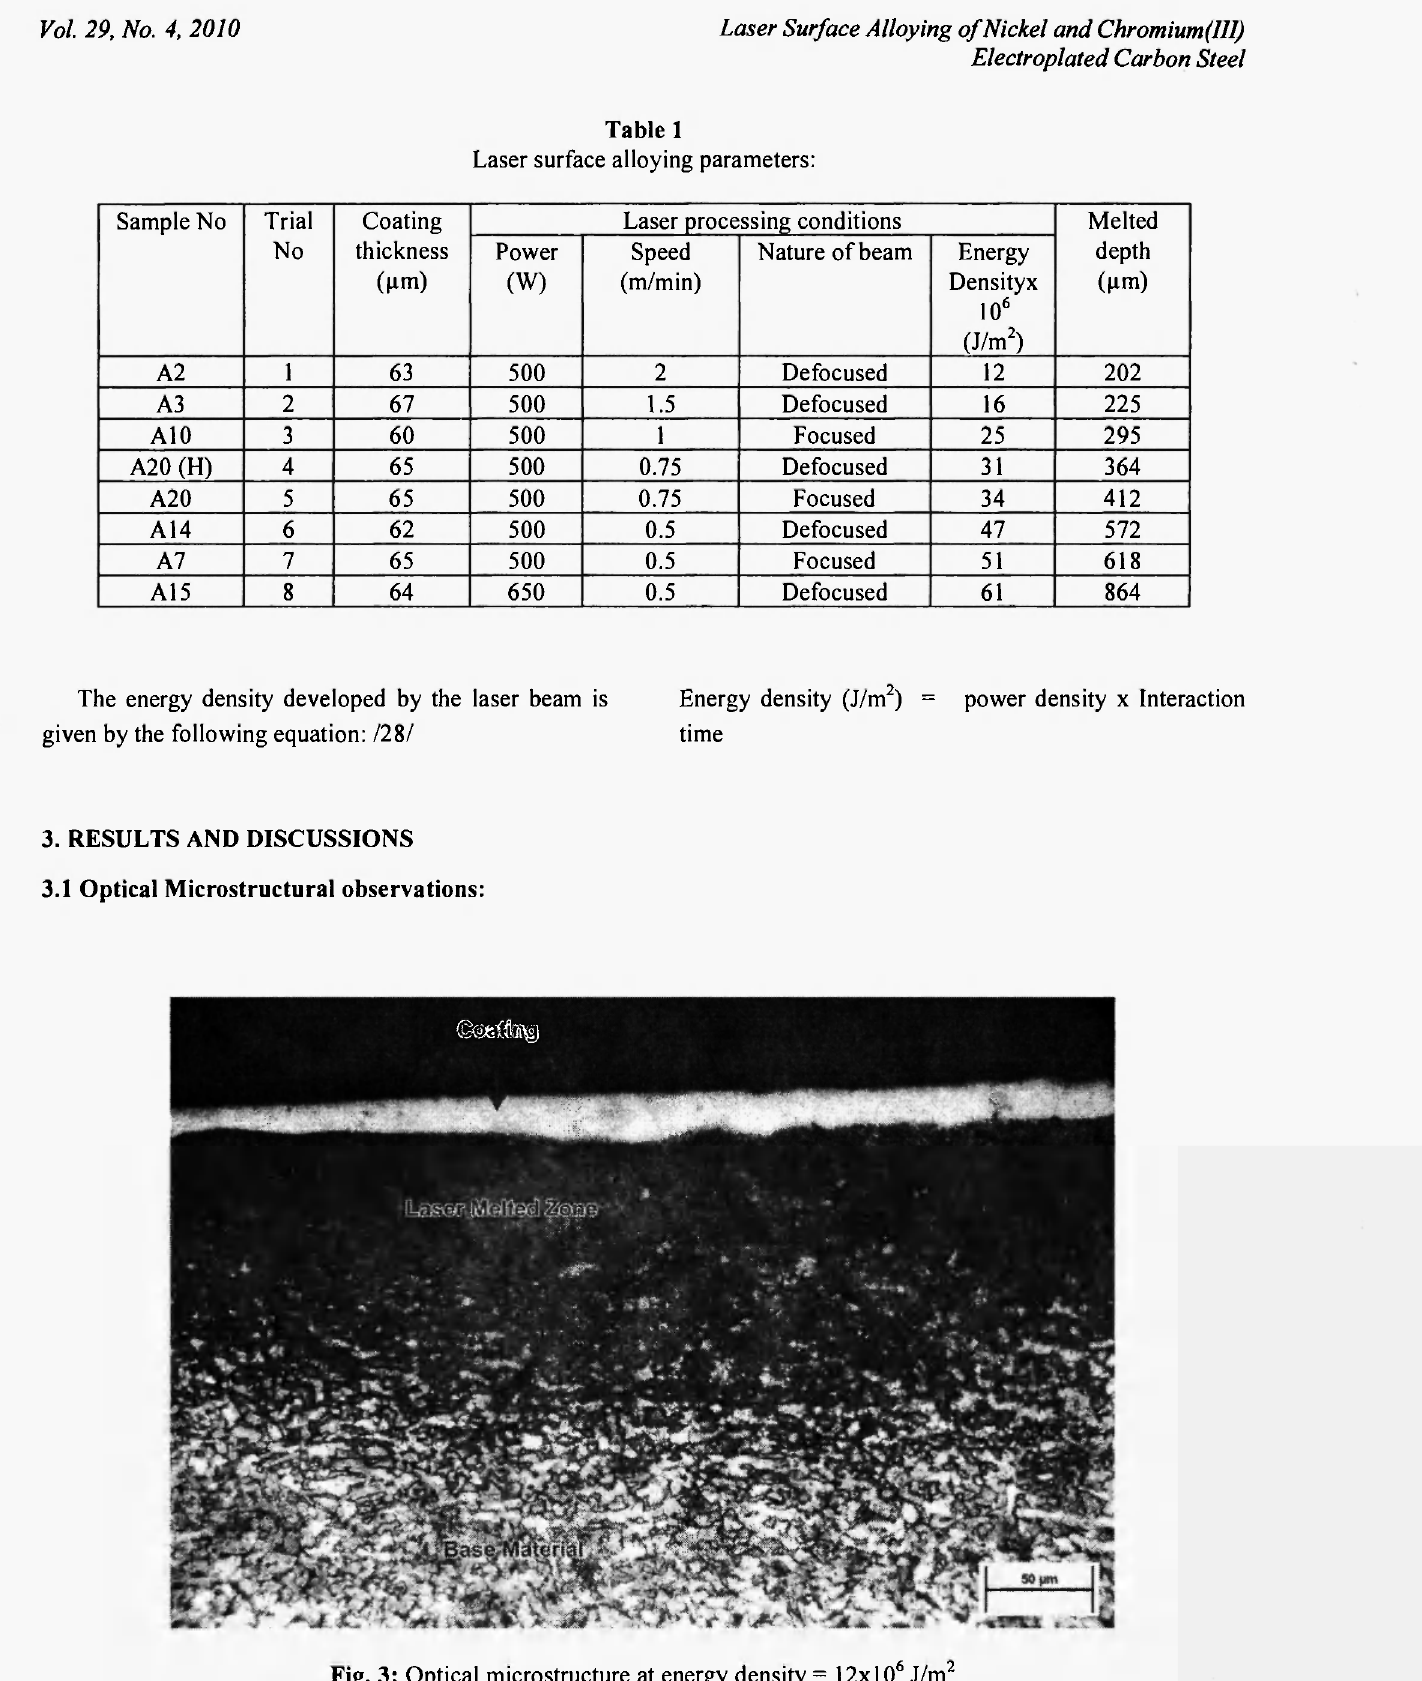
Fig. 3: Optical microstructure at energy density = 12xl0 6 J/m